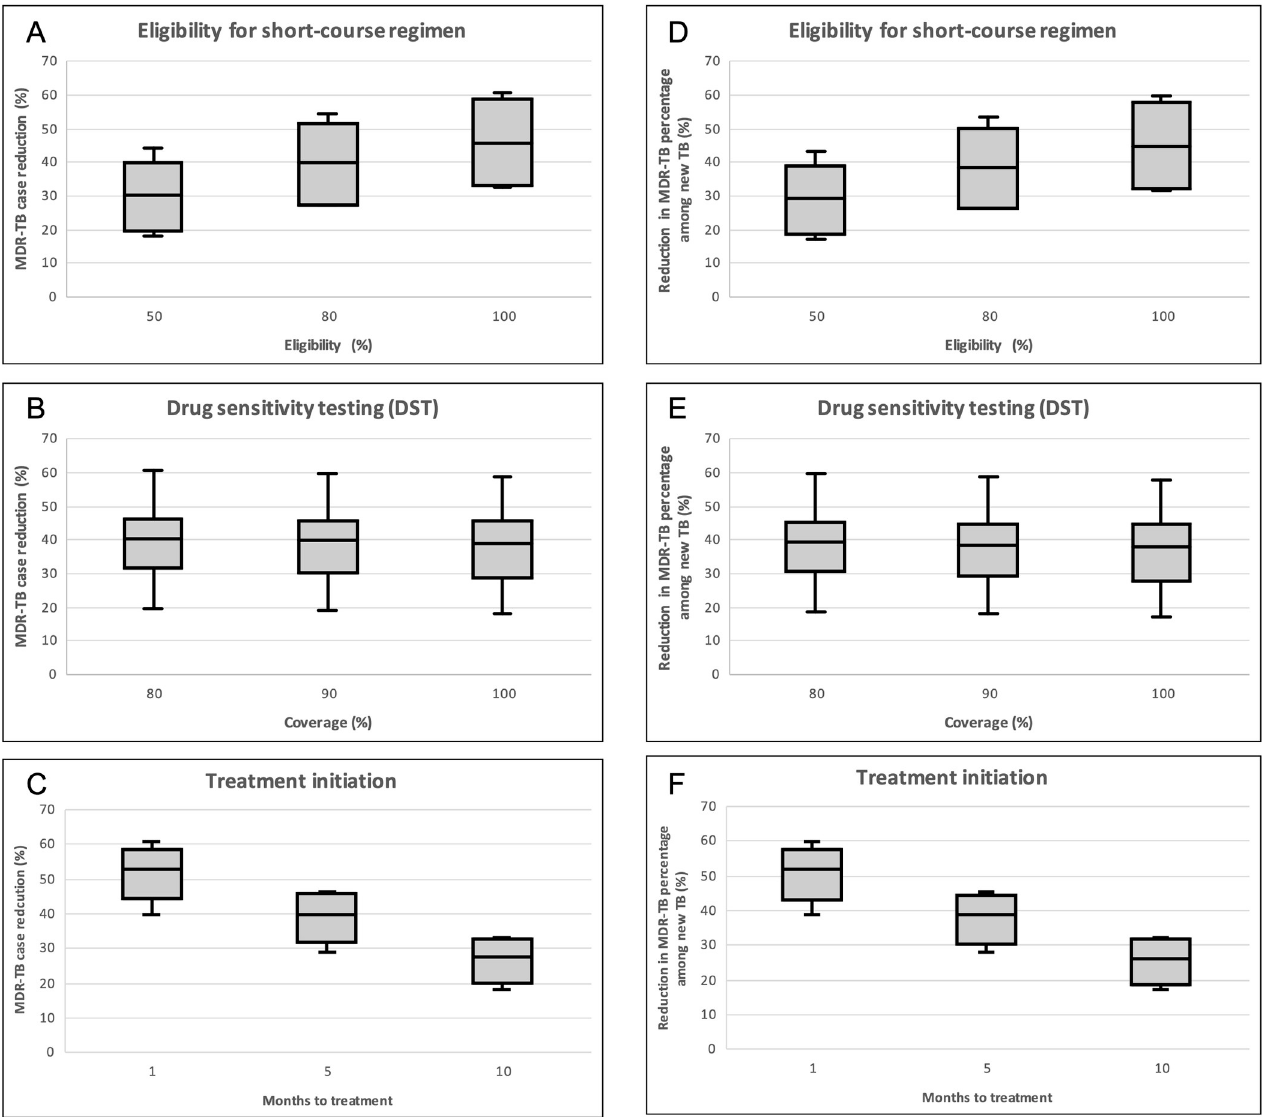
Fig 5. Multi-way analysis focusing on three factors (eligibility, DST and treatment initiation) influencing the impacts from the short-course regimens (Table 2). The outcomes in term overall MDR-TB cases (A-C) and MDR-TB percentage among new cases (D-F) from 81 combinations were simulated and compared to the baseline (using the standard regimen). Fig 3 categorized the outcomes by eligibility (A & D), DST (B & E), and treatment initiation (C & F)., shown in boxplots.